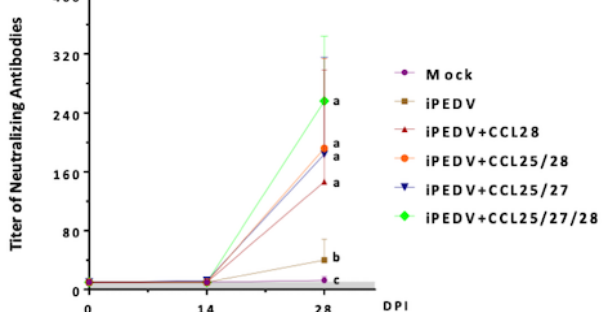
Figure 5. The titers of viral neutralizing (VN) antibodies against PEDV in each group at 0, 14, and 28 days post-immunization (DPI). Data are presented as the mean titer ± standard deviation. The gray zone is the background of the viral neutralizing assay. Statistically significant differences are present among a, b, and c ( p < 0.05).